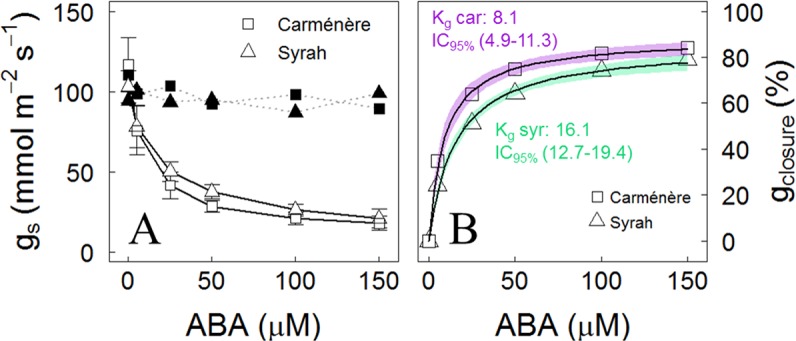
Stomatal response to increasing doses of ABA in grapevine leaves. (A) Average stomatal conductance when individual leaves of Carménère (squares) and Syrah (triangles) were fed with increasing doses of 0, 5, 25, 50, 100, and 150 µM of ABA for 50 min at each concentration. White symbols with straight line represent the progression response of gs to increasing ABA doses and black symbols with segmented lined shows gs at equal periods but in leaves fed with water as control. Mean ± SD are presented, n: 7. (B) Percentage of stomatal conductance reduction (gclosure) from the initial value from each leaf. The gclosure response to ABA was fitted using a Michaelis–Menten curve. For each curve, the predicted mean (black solid line) and the 95 % CI (segmented lines) are shown. The ABA concentration at which gs is reduced to its half (Kg) for each variety are presented.